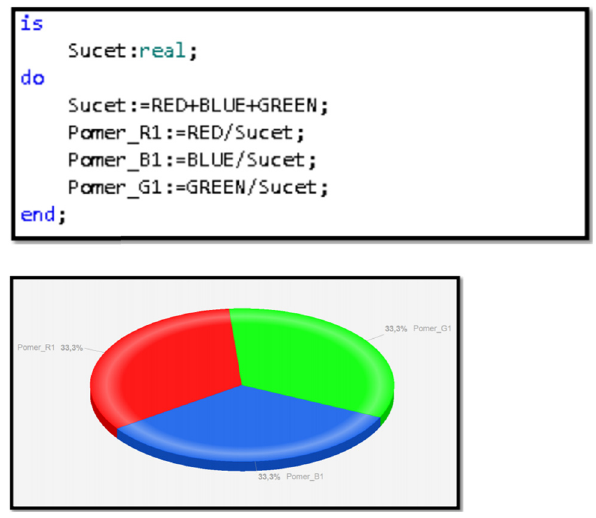
Figure 10: Program sequence and method of its visualization.